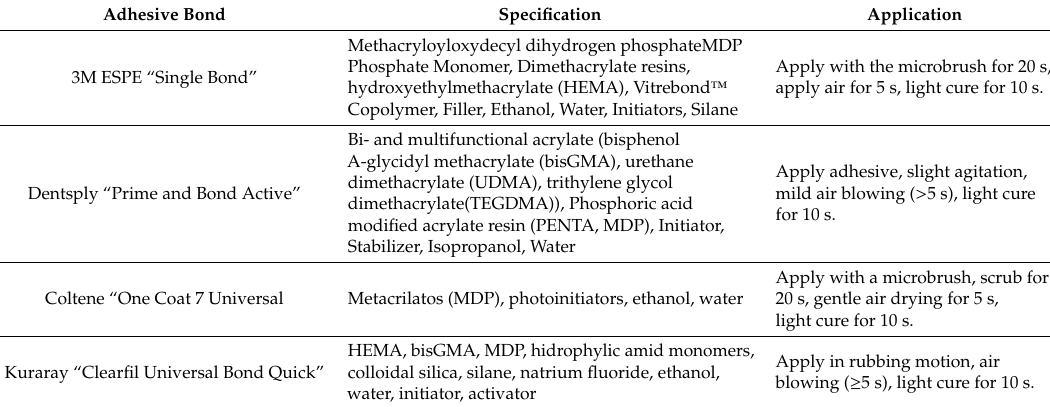
Table 1. Chemical properties and application protocol of 4 adhesive